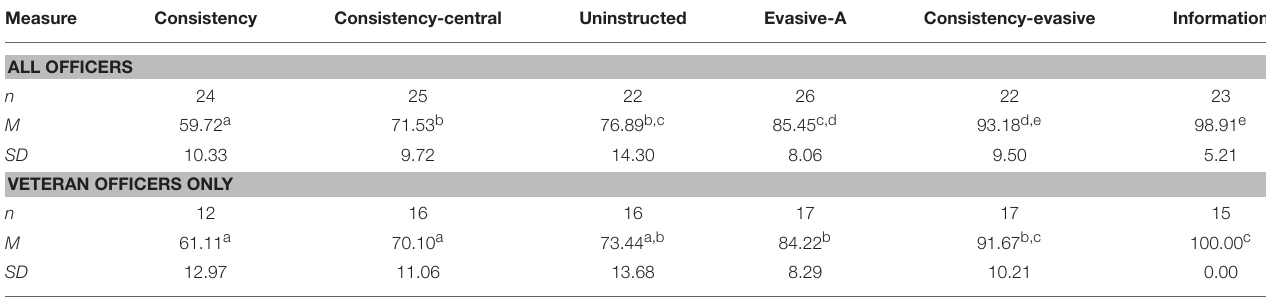
TABLE 3 | Sample size, mean accuracy rates, and standard deviations for the separate conditions in Experiment 2.